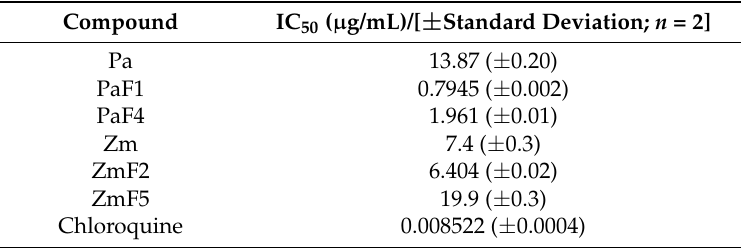
Table 4. IC 50 values for the antiplasmodial activities of P. angolensis and Z. mucronata